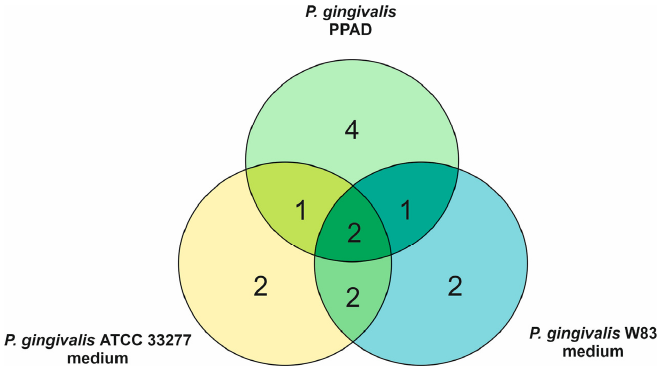
Figure 3. Venn diagram indicating overlapping and specific C. albicans proteins identified as citrullinated after treatment of the fungal cells with culture supernatants collected after P. gingivalis growth and with P. gingivalis